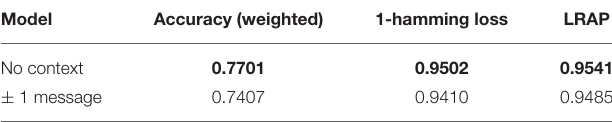
TABLE 5 | Results of behaviour classification for individual messages.